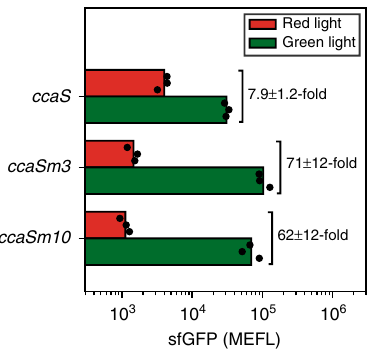
Fig. 5 CcaS miniaturization increases light response. B. subtilis expressing PPM v0.3, TOM v0.2, and either LSM v0.2 ( ccaS ), LSM v0.3a ( ccaSm3 ), or LSM v0.3b ( ccaSm10 ) were grown at 48 combined levels of IPTG and xylose, under saturating red or green light. sfGFP fl uorescence values shown here correspond to the inducer concentrations that resulted in the highest fold-change in response to light for each ccaS variant (Supplementary Figs. 16, 19, 20). Bars show the mean of three experiments run on separate days. Dots show values of individual experimental replicates. Source data is available in the Source Data fi